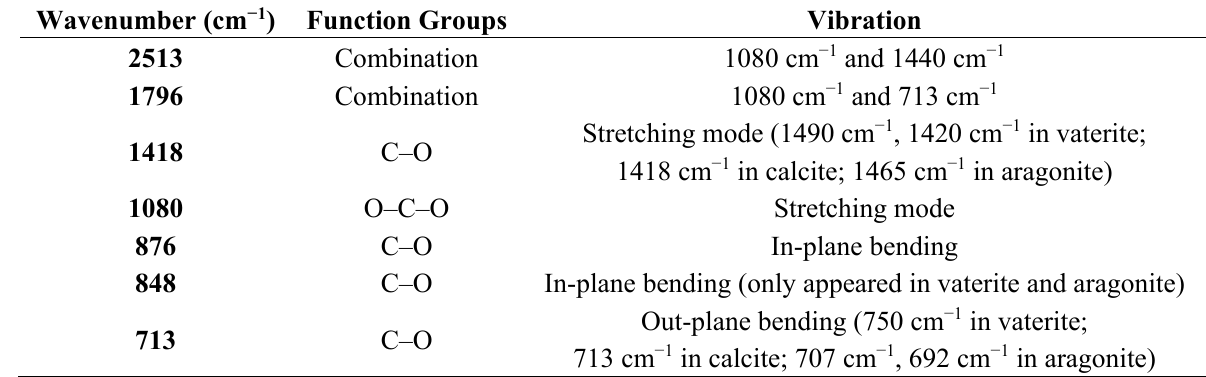
Table 1. Assignment of peaks for CaCO 3 .